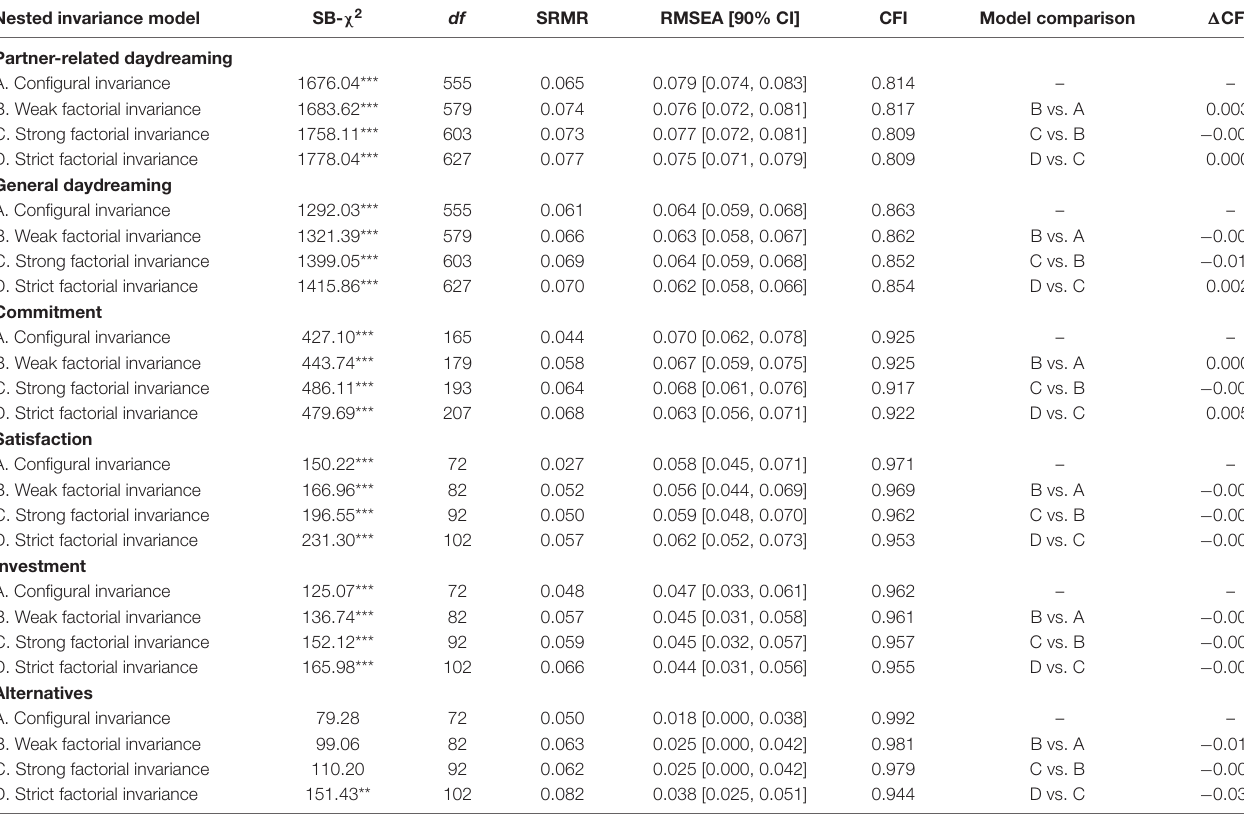
TABLE 2 | Model-fit indices and nested model comparisons from the analyses of longitudinal measurement invariance. Nested invariance model SB- χ 2 df SRMR RMSEA [90% CI] CFI Model